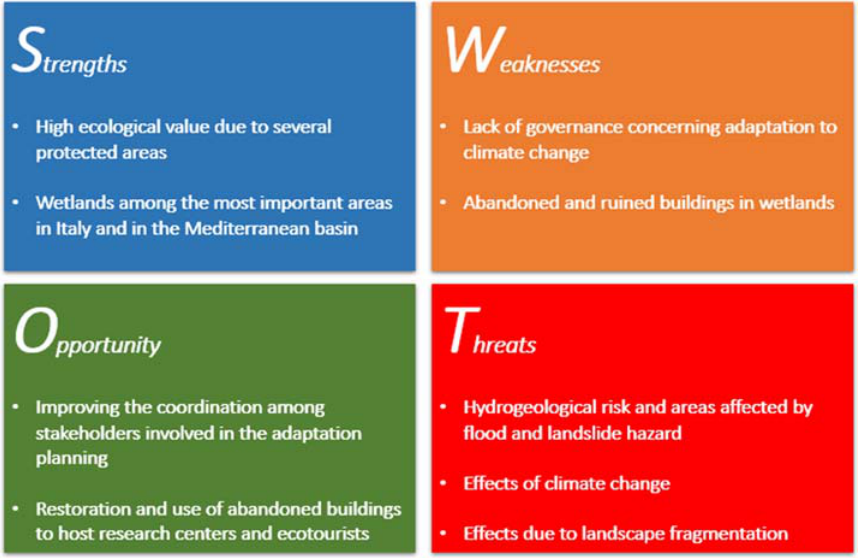
Figure 2. Metropolitan city of Cagliari: SWOT analysis.